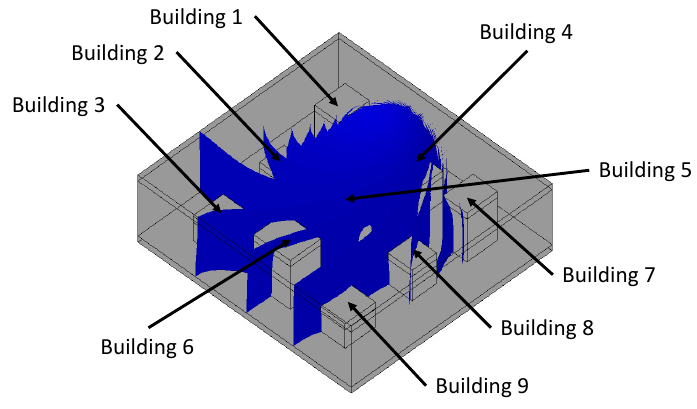
Figure 7. Chemical agent isosurfaces at T = 10,800